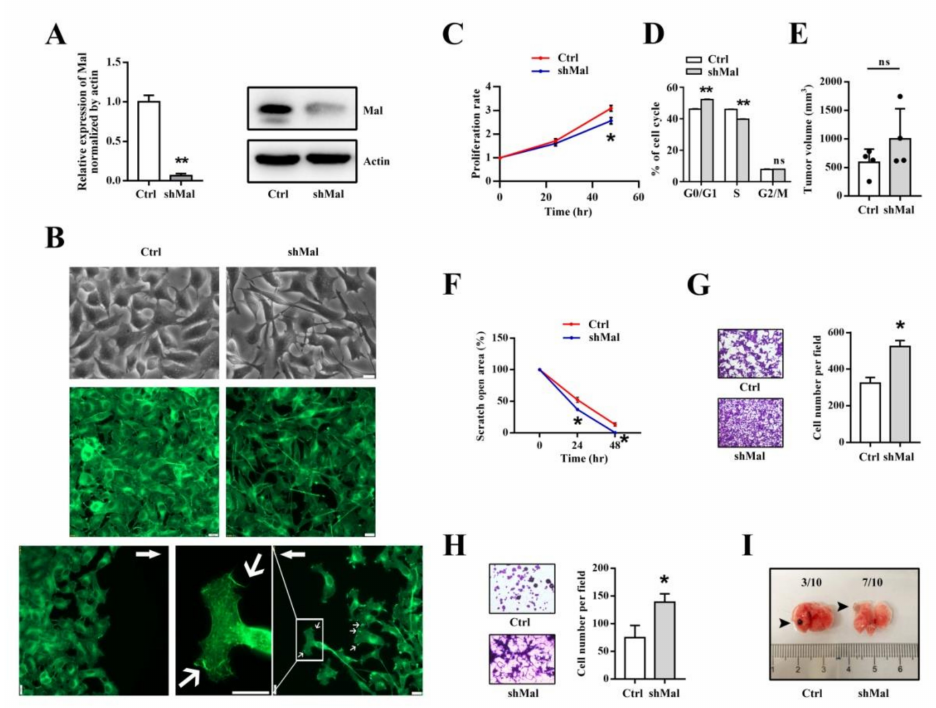
Figure 5. Mal was necessary for suppressing the migratory and invasive traits of metastatic melanoma cells. ( A ) The knockdown of Mal gene expression was validated with qRT-PCR and Western blotting. The relative Mal gene expression levels are compared to each other (means ± SEM, n = 3). Mal’s molecular weight: 18 kDa; actin’s molecular weight: 43 kDa. ( B ) The knockdown of Mal gene expression changed the cell shape and altered the actin cytoskeleton of steady or migrating cells. The green fluorescent signals indicate actin filaments. The arrows indicate the directions of migration fronts. The thin arrows indicate microspike-like structures. Bars: 22 µ m. ( C ) The knockdown of Mal gene expression slightly reduced the proliferation rate. The relative proliferation rates were determined by 3-(4,5-dimethyl-2-thiazolyl)-2,5-diphenyl-2-H- tetrazolium bromide (MTT) and were compared to each other (means ± SEM, n = 3). ( D ) The knockdown of Mal gene expression slightly delayed the progress of the cell cycle. The percentages of cells at various phases (G0/G1, S, and G2/M) were determined by flow cytometry (means ± SEM, n = 3, ns: not significant). ( E ) The knockdown of Mal gene expression had no effect on the tumor formation rate. The averaged tumor volumes were compared to each other (means ± SEM, n = 4, ns: not significant). ( F ) The knockdown of Mal gene expression increased the migration rate in wound healing. The relative scratch open areas were compared to each other (means ± SEM, n = 3). ( G ) The knockdown of Mal gene expression increased the migration rate through the Transwell chambers. A representative image is shown on the left of the panel, and the averaged cell numbers were compared to each other, as shown on the right (means ± SEM, n = 6). ( H ) The knockdown of Mal gene expression increased the invasion rate through Matrigel-coated Transwell chambers. A representative image is shown on the left of the panel, and the averaged cell numbers were compared to each other, as shown on the right (means ± SEM, n = 6). ( I ) The knockdown of Mal gene expression increased the frequency of metastasis-focus-positive lungs. A representative image is shown. The arrowheads indicate metastasis foci. The frequencies are inscribed at the top of the image. Ctrl: mock control; shMal: short hairpin RNA interference of Mal . * p < 0.05 and ** p < 0.01 are generated by the t